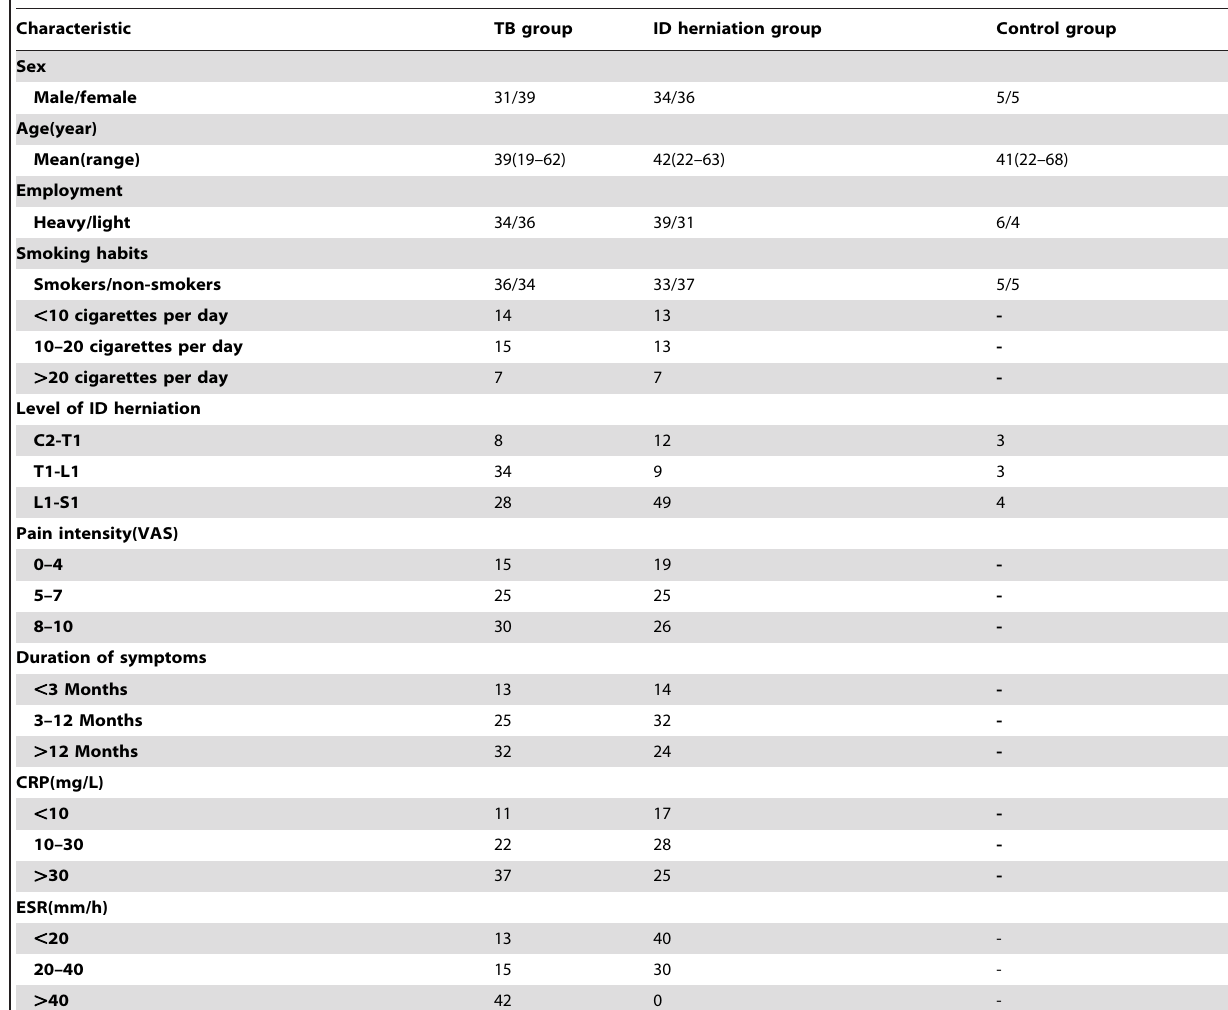
Table 1. Patient clinical